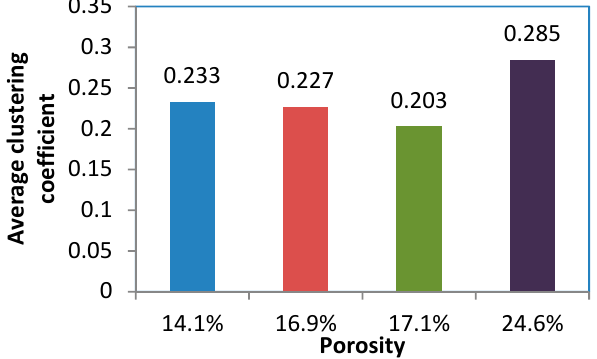
Figure 7. Average clustering coefficient of sandstone pore network. Table 2. One-way ANOVA.